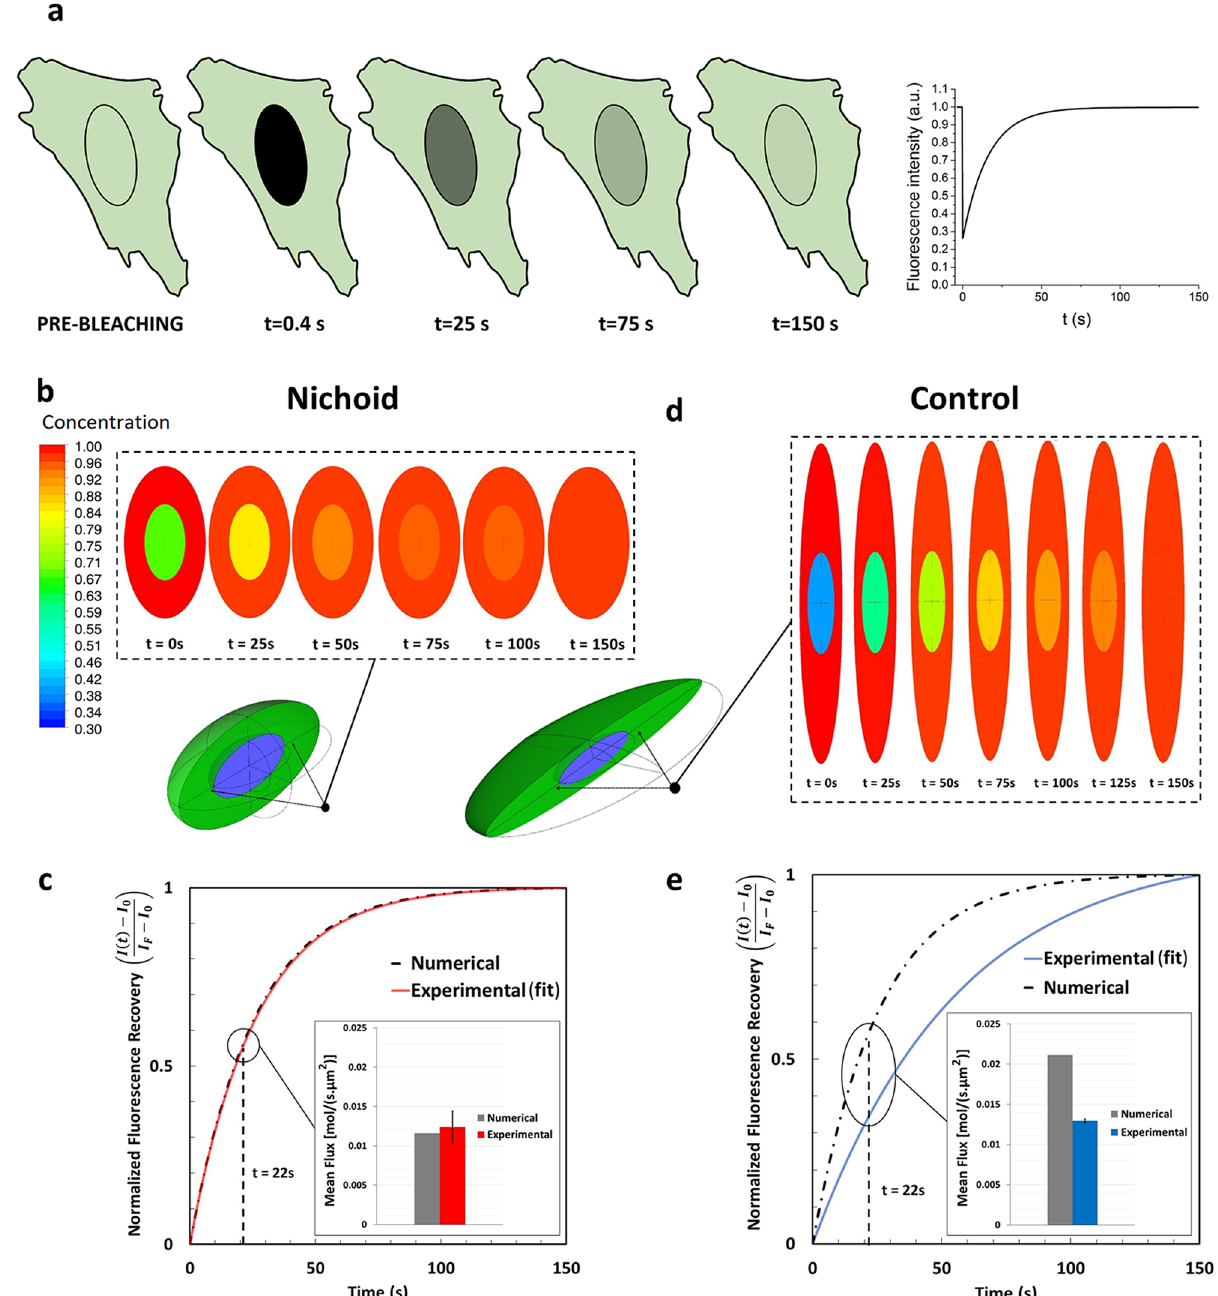
Figure 5. Passive Nucleo-cytoplasmic protein fluxes of proteins within the Nichoid artificial niche. ( a ) Representative sketch of FRAP experiment to study fluorescent protein translocation into the cell nucleus and a representative plot of the fluorescence intensity recovery curve. The software used to create the images are Microsoft PowerPoint 2018 (https ://produ cts.offic e.com/it-it/power point ) and OriginPro 2019 (https ://www. origi nlab.com/origi n). ( b ) Contour map of GFP concentration on xz-plane at different time points for cells grown into the Nichoid (from numerical simulation). The software used to create the images is Ansys 2019 R2 (www.ansys .com) ( c ) Comparison of recovery curves and mean fluxes at 22 s after photobleaching for cells grown in the Nichoid: numerical simulation (black dotted curve), FRAP experiments (red curve). ( d ) Contour map of GFP concentration on xz-plane at different time points for cell on Control cells (from numerical simulation). The software used to create the images is Ansys 2019 R2 (www.ansys .com) ( e ) Comparison of recovery curves and mean fluxes at 22 s after photobleaching for cells grown on a flat control substrate: numerical simulation (black dot), FRAP experiments (blue). The vertical axis of the graphs ( d ) and ( e ) shows the normalized fluorescence intensity for FRAP and normalized concentration for the numerical